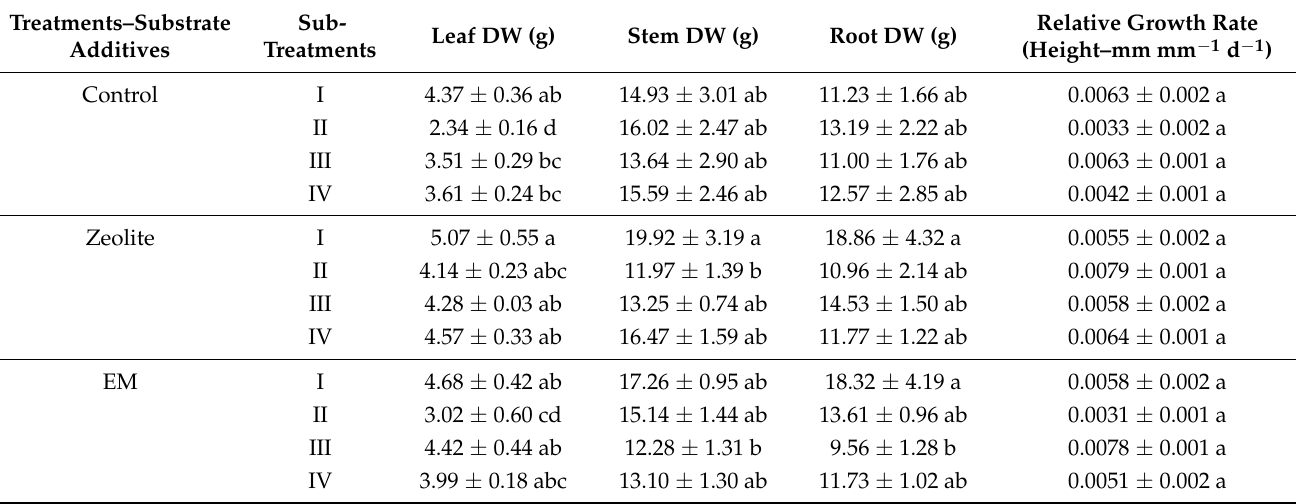
Table 1. Growth parameters of the apple plants at the end of the